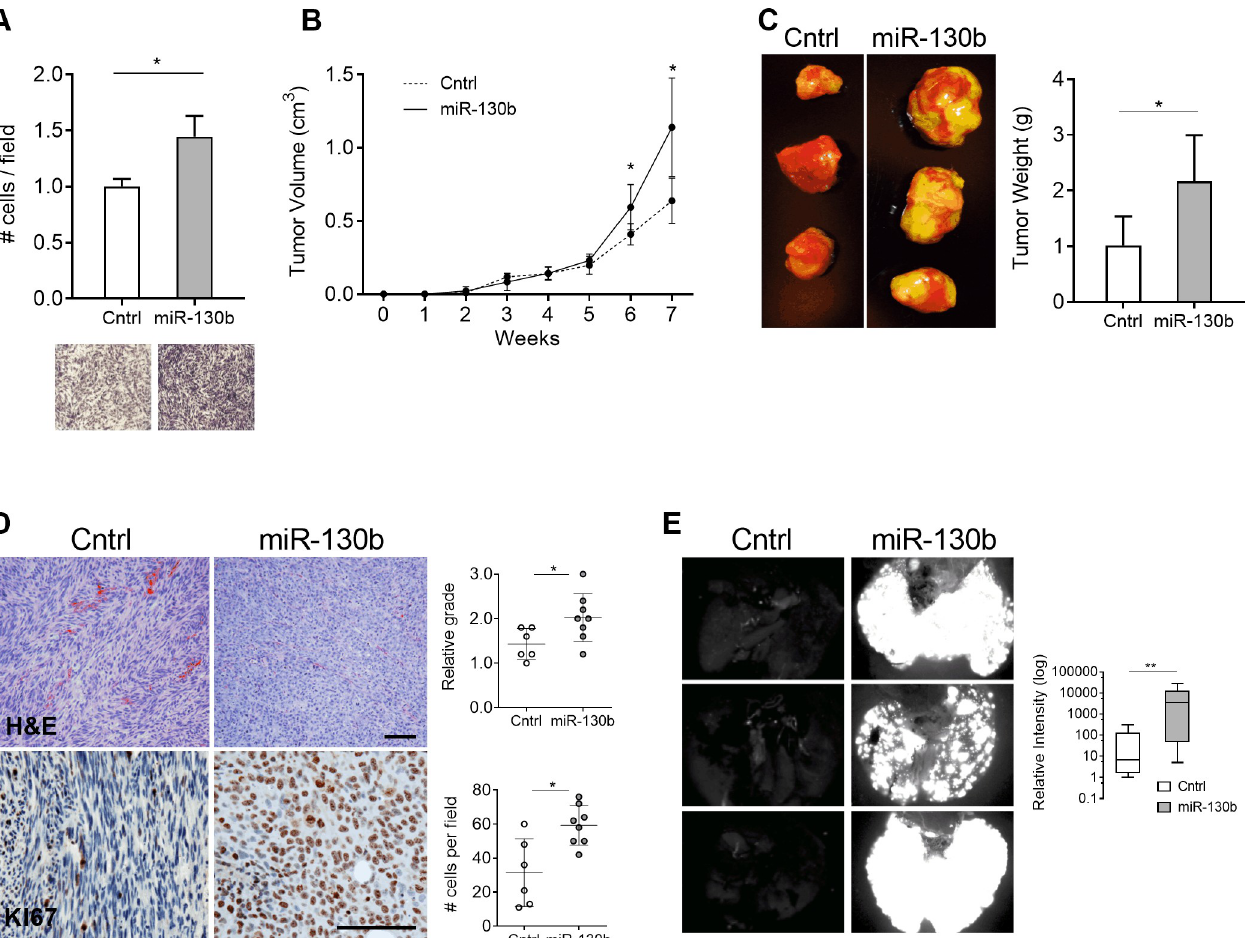
Fig 2. MiR-130b overexpression enhances LMS invasion and metastasis. (A) Transwell assay showing relative invasion of miR-130b overexpressing LMS1 cells and control 18 h after seeding (n = 3, per group). Images show crystal violet staining of membrane inserts. Cell counts were normalized to the control group. (B) Primary tumor growth following subcutaneous injection of control (n = 6) and miR-130b (n = 8) transduced LMS1 cells in immunocompromised mice. (C) Representative images of primary tumors at the 7-weeks endpoint ( left panel ). Mean weight of resected primary tumors at endpoint for control (n = 6) and miR-130b (n = 8) groups ( right panel ). (D) H&E ( top panels ) and Ki67 ( bottom panels ) stained primary tumors removed at endpoint. Scale bar: 100 μ m. Plots show histological grading of tumor architecture (1 = fascicular; 3 = storiform) ( top ), and number of Ki67 positive cells per field ( bottom ). (E) Fluorescent images of GFP positive nodules in whole lungs recovered at endpoint from control and miR-130b transduced LMS1 cells. Box plot ( right ) depicts quantification of GFP signal intensity in lungs of control (n = 6) and miR-130b (n = 8) groups. Statistical analyses were performed by two-tailed students t-test; � P < 0.05, �� P <